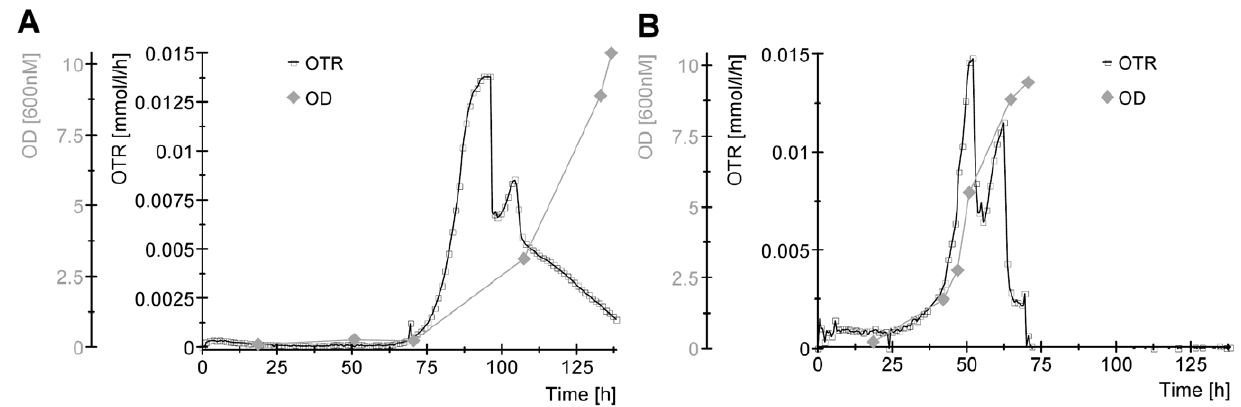
Figure 7. Growth of an E.coli strain engineered to produce biodiesel on CTec2 hydrolysate (A) and control sample containing 2% glucose and 1% xylose (B). Oxygen transfer rate (OTR), and cell density (OD 600 ) were monitored during the fermentation to determine the impacts of the hydrolysate on growth and respiration.